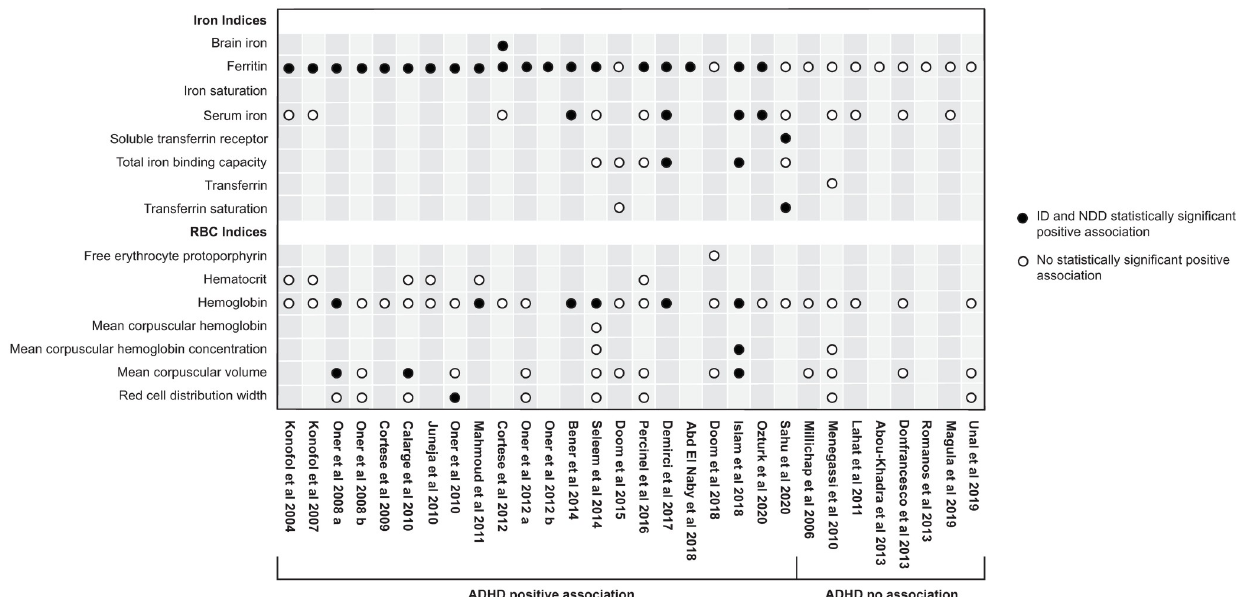
Fig 4. Overview of biomarkers used in ADHD association studies.